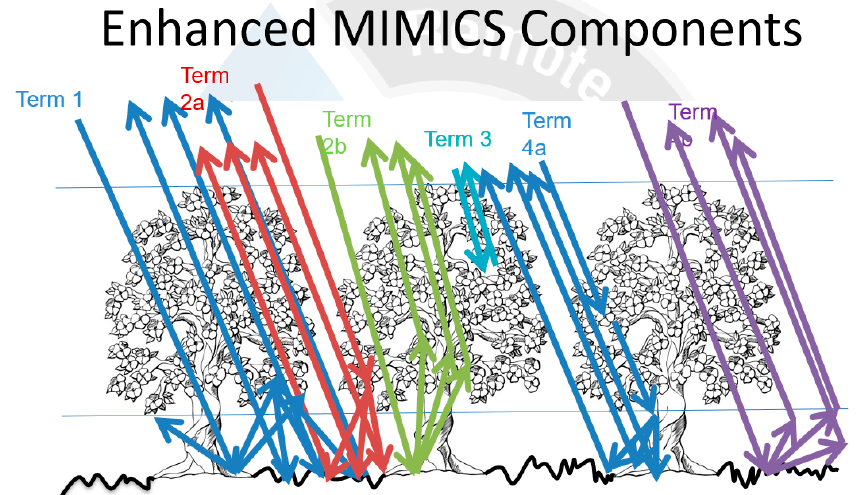
Figure 1. Backscattering components from vegetation with a canopy layer in enhanced MIMICS.